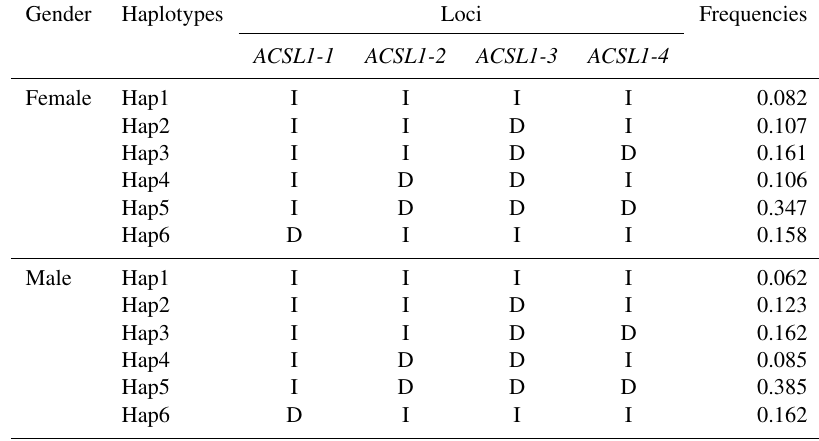
Table 3. Haplotypes of the four sites within the ACSL1 gene in Dezhou donkeys of different genders.